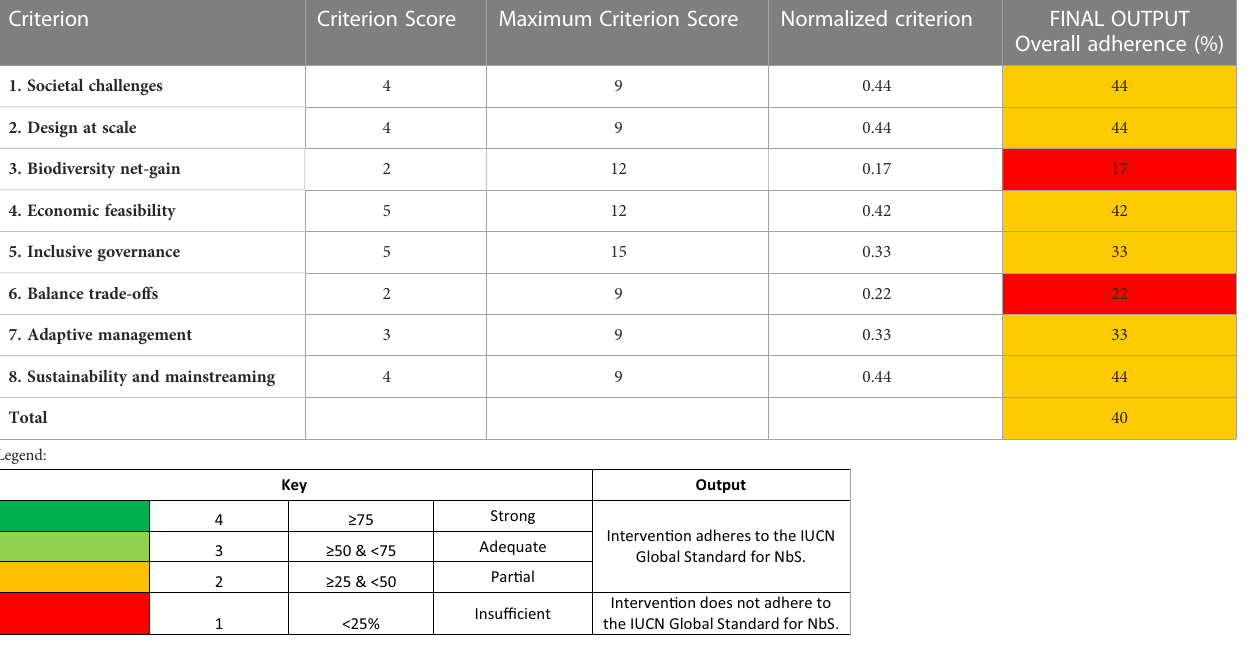
TABLE 3 Overall result of the assessment of Zanzibar seaweed farming, according to the IUCN Global Standard for NbS ™ ’ s self-assessment tool (results were discussed and re fi ned with the NbS IUCN team).